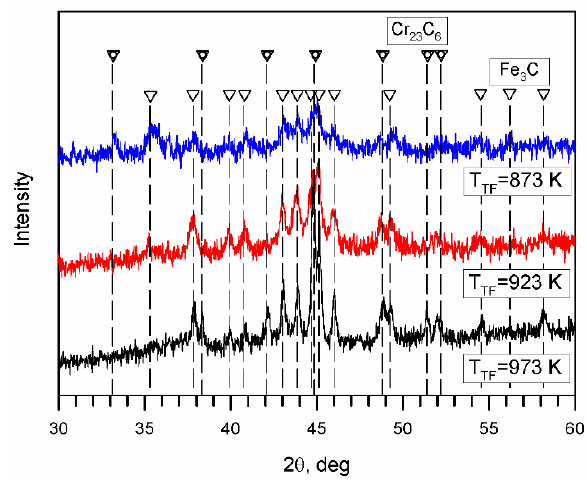
Figure 7. X-Ray diffraction of powder residuals obtained by a method of electrolysis from the tempformed specimens.